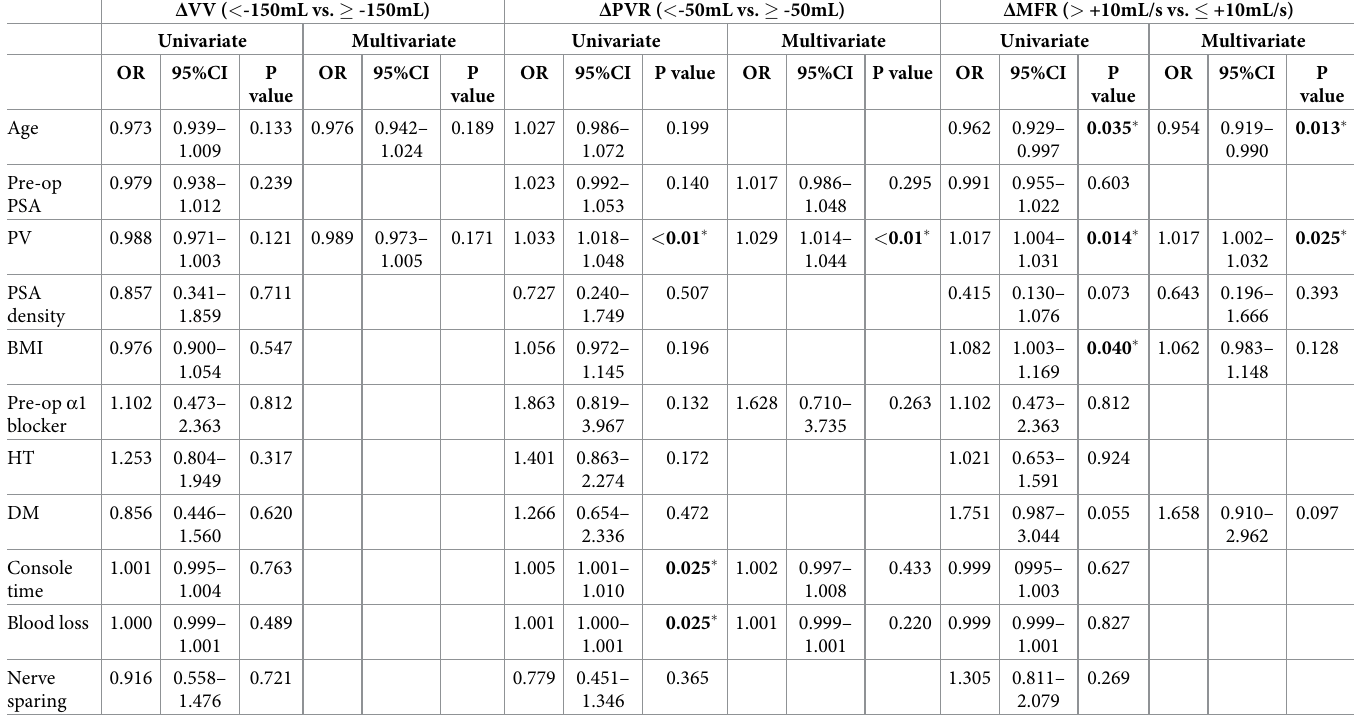
Table 3. Analysis of risk factors for perioperative change in uroflowmetry parameters. Δ VV ( < -150mL vs. �